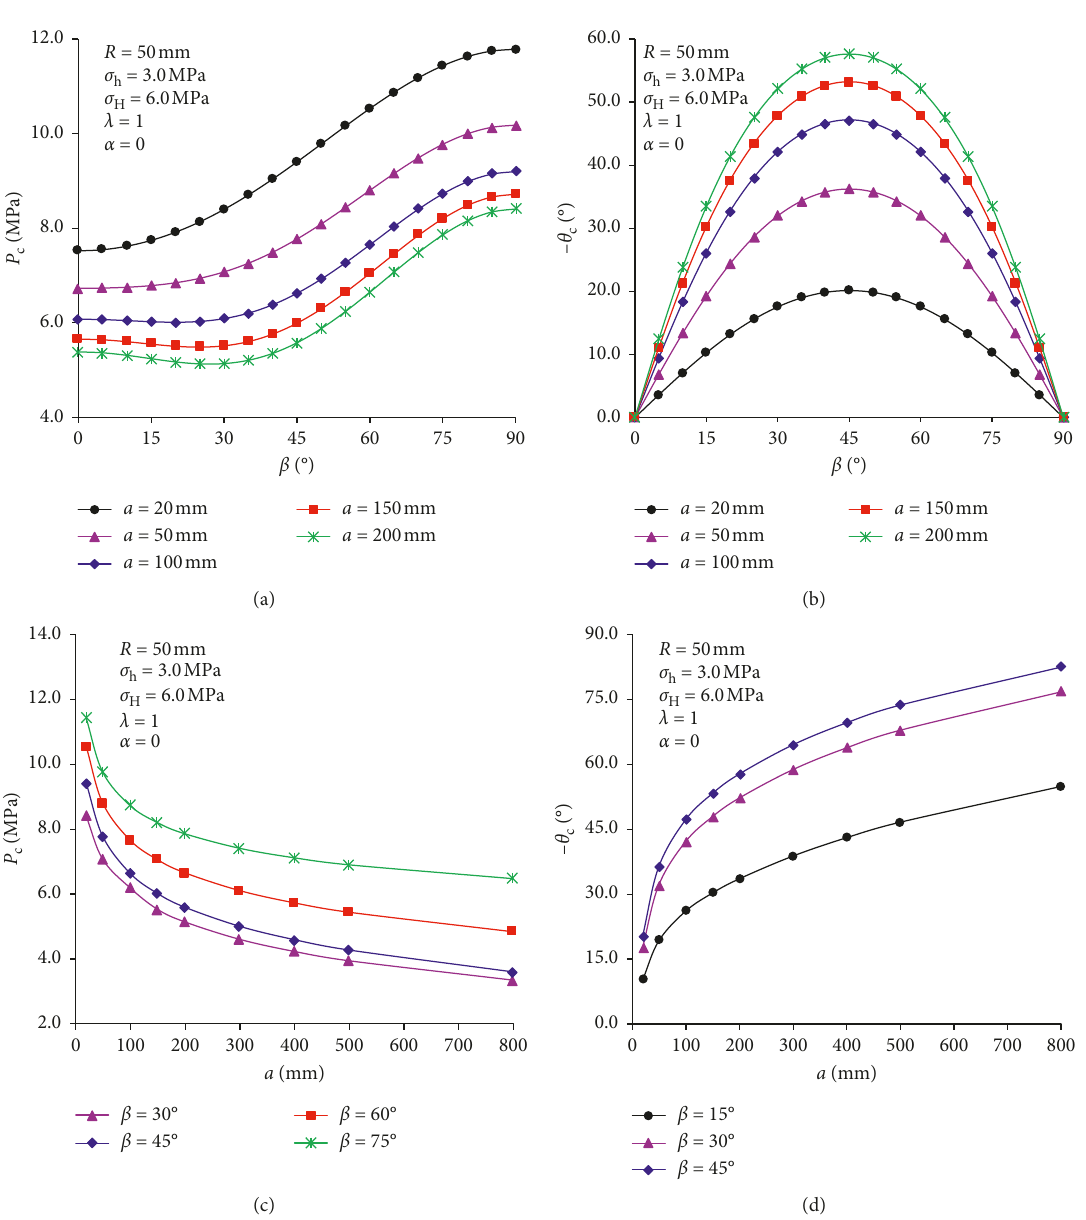
Figure 12: Effect of the perforation length on the critical water pressure and critical initiation